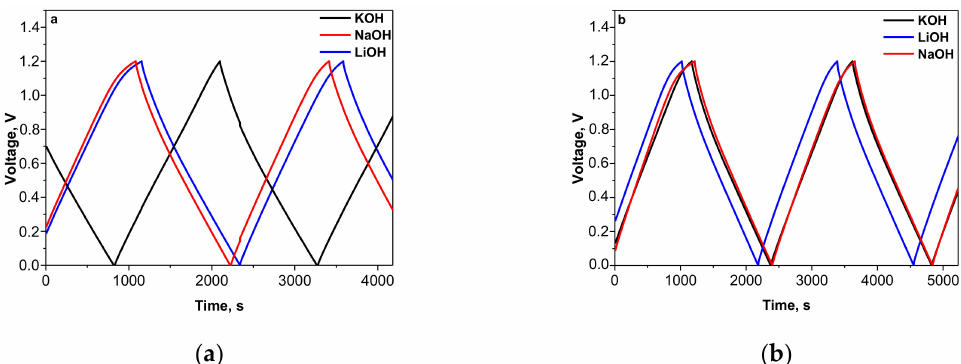
Figure 1. Galvanostatic charge-discharge curves of symmetric supercapacitors with YP-50F ( a ) orYP-80F ( b ) electrodes cycled in basic electrolytes at a current rate of 60 mAg − 1